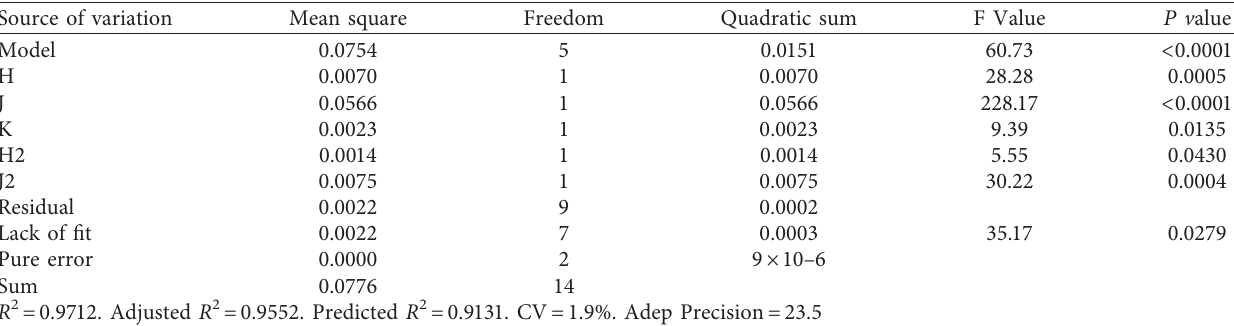
Table 8: ANOVA of the modified model of Box-Behnken